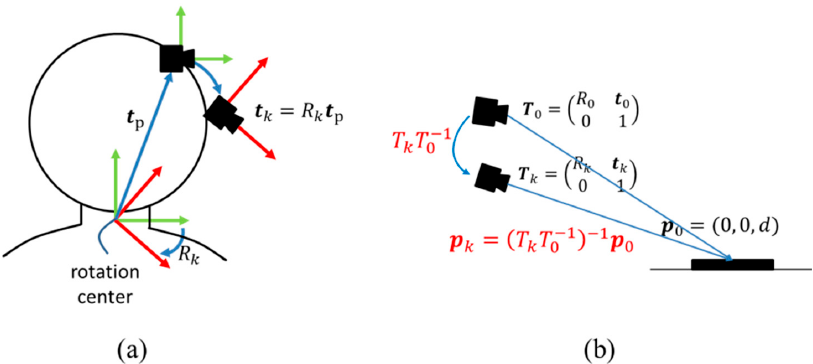
Figure 4. Object movement by the rotation of the head. The camera undergoes translation when the head is rotated, because the rotation center of the head does not correspond to the center of the camera.